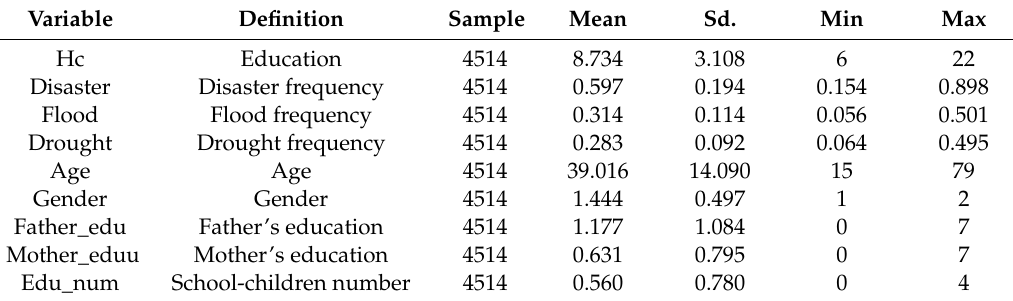
Table 6. Statistical description of China Labor Dynamics Survey Data (CLDS)